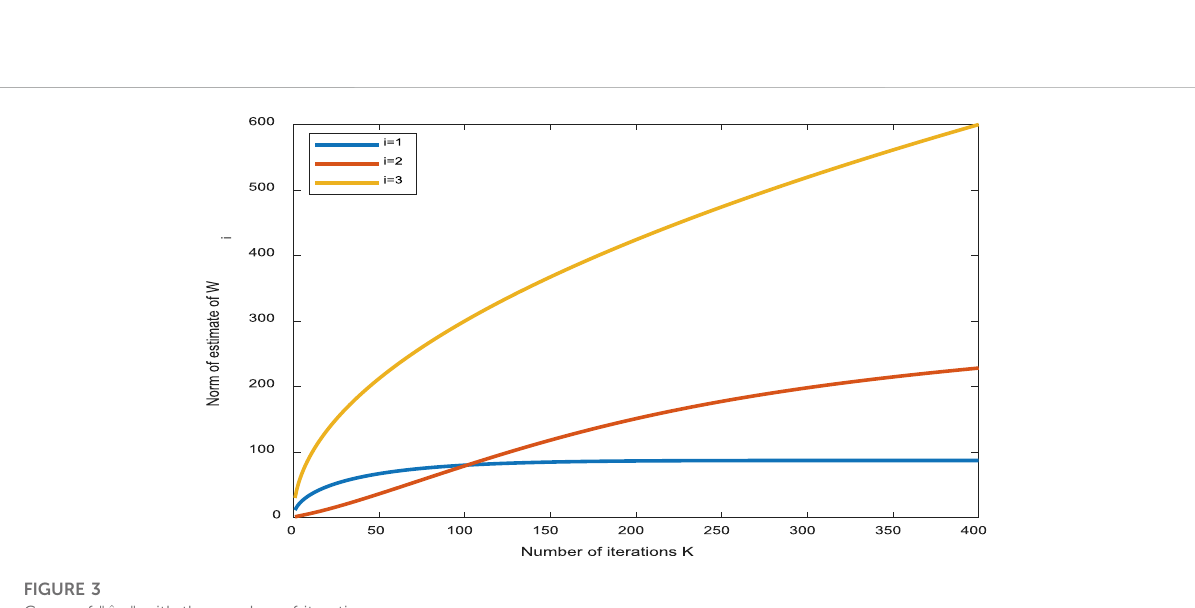
FIGURE 3 Curve of (cid:3) ^ ω i , k (cid:3) with the number of